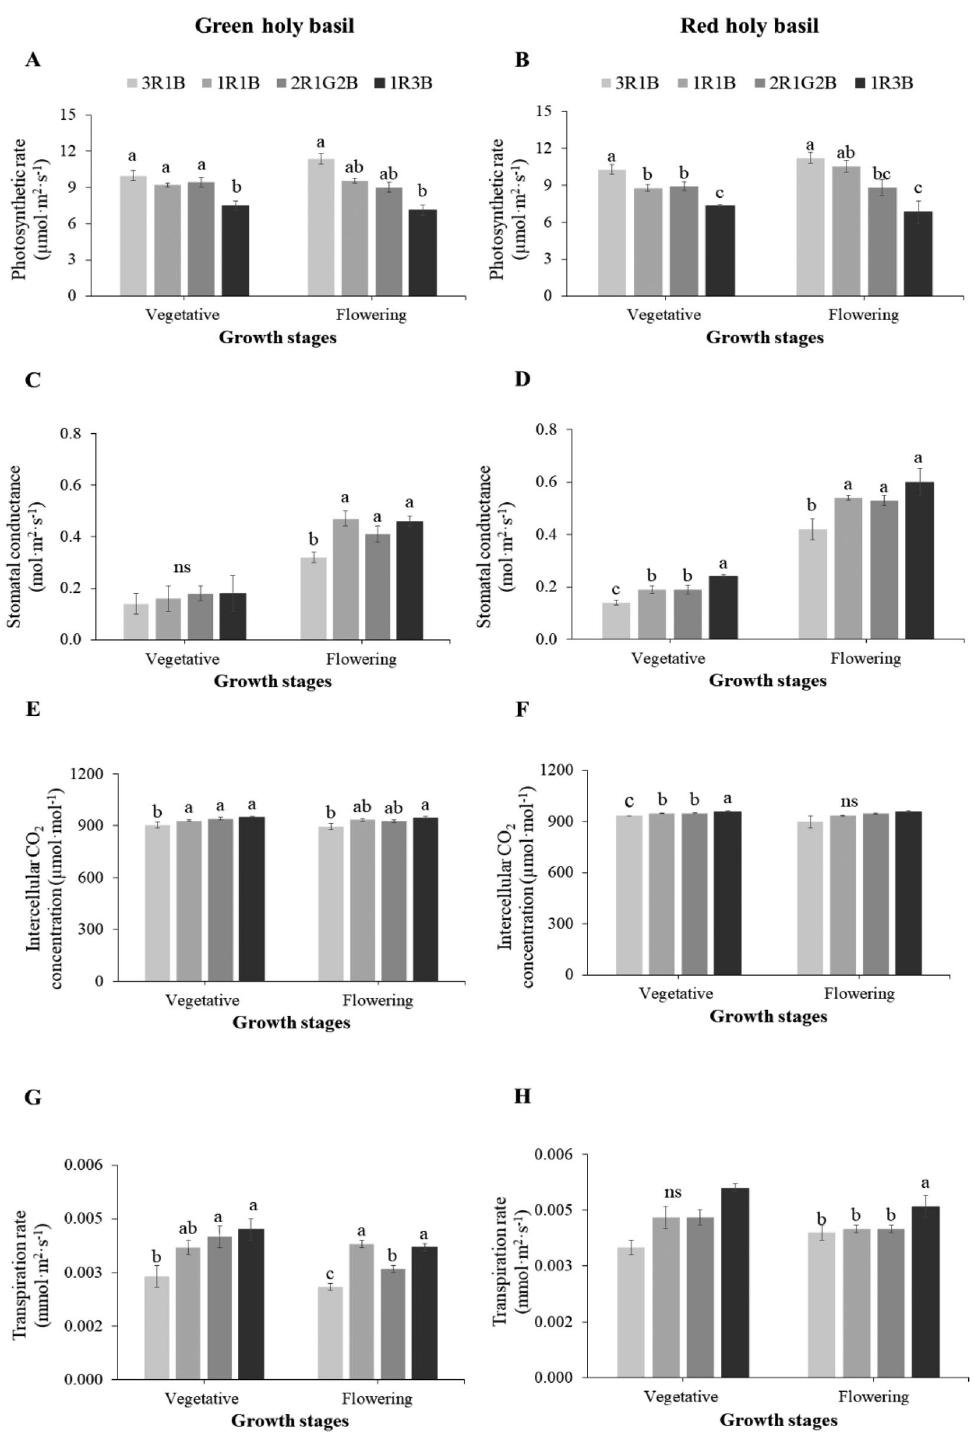
Figure 3. Effects of different light spectrum treatments on net photosynthesis rate ( Pn , A , B ), stomatal conductance ( g s , C , D ), intercellular CO 2 concentration ( Ci , E , F ), and transpiration rate ( E , G , H ) of green and red holy basil at vegetative and flowering stages. R, G and B represent the red, green and blue llight spectra, respectively, and number before the letters stand for the ratio of each lighrt spectra. Values are represented as mean ± SE (n = 4). ANOVA was performed followed by mean comparison with DMRT. Lower-case letters above bars indicate significant difference (p < 0.05); “ns” indicates no significant difference. Bars indicate standard